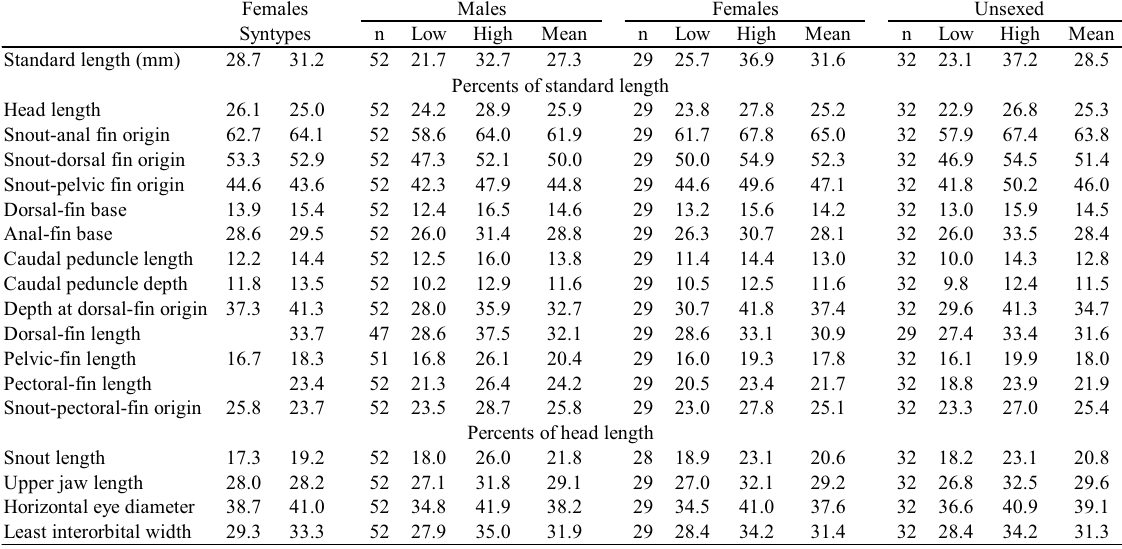
Table 1. Morphometrics of Odontostilbe pulchra (syntypes MNHN 0000-9593) (Trinidad drainages, INHS 40081, INHS 40101, ROM 41069, ROM 44764, USNM 290410; río Orinoco basin, ANSP 139450, ANSP 139579, ANSP 139472, MCP 14975, MCP 38863; rio Amazonas basin, INPA